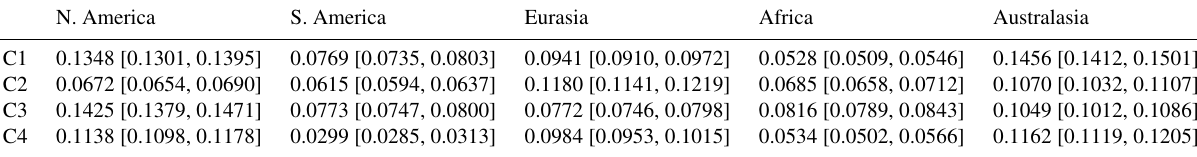
Table D2. Same as Table D1 but for July–September 2014. N.